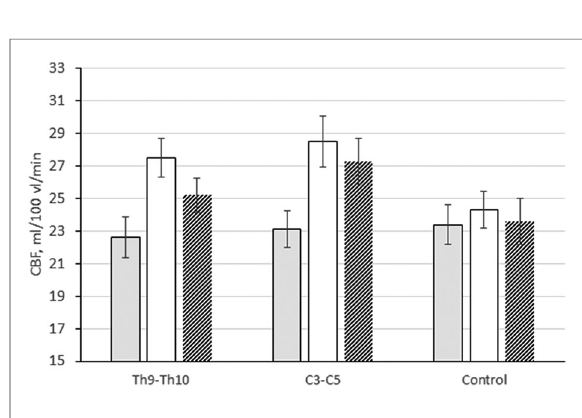
FIGURE 4 Changes in CBF (ml/100 ml/min) in the white matter of the brain in patients with epidural electrode placement at different levels: Th9 – Th10, subgroup 1; C3 – C5, subgroup 2; control, control group.